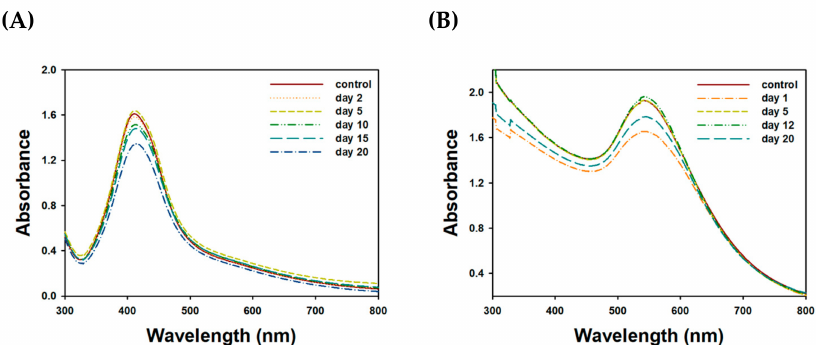
Figure 9. Assessment of on-the-shelf colloidal stability for 20 days at ambient temperature. UV-visible spectra of ( A ) TF-AgNPs and ( B )